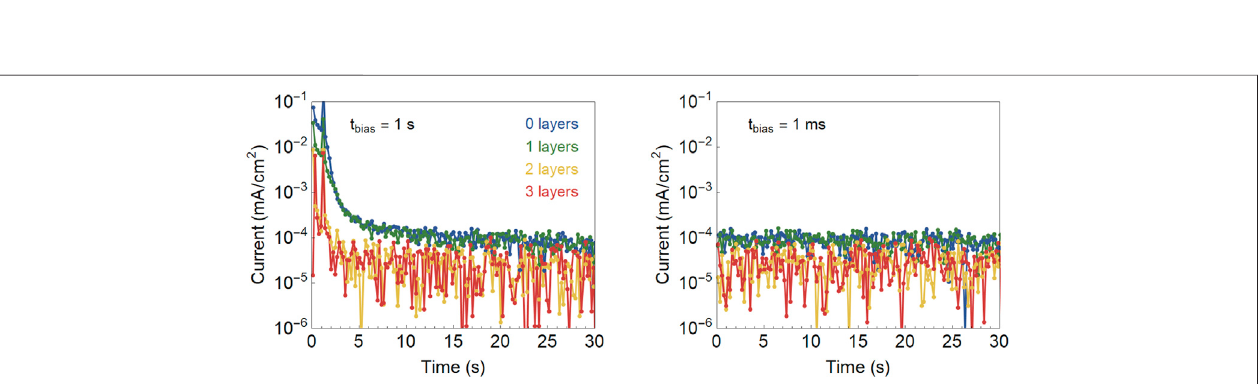
Frontiers in Electronics |